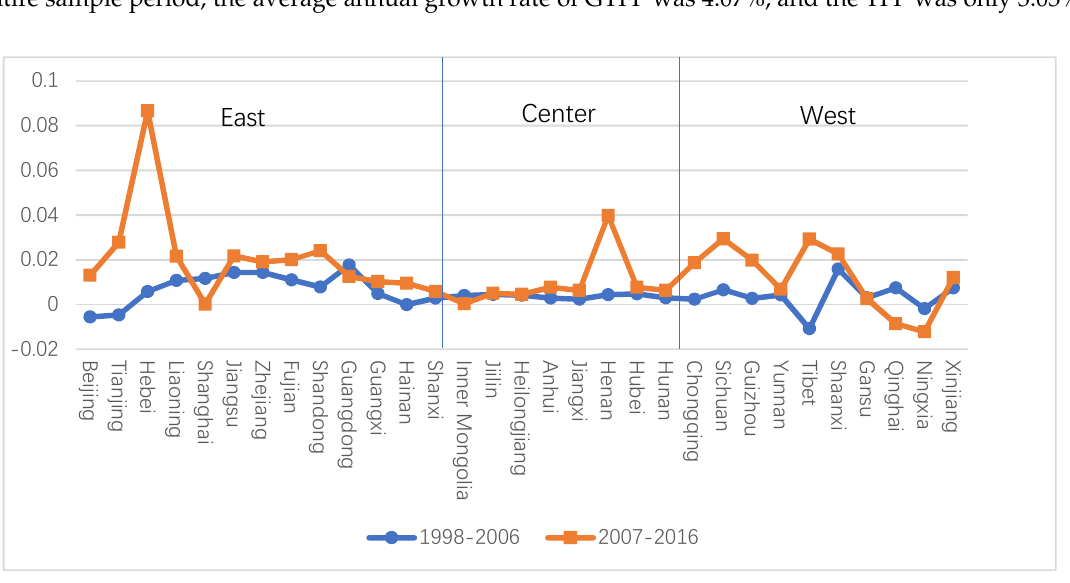
Figure 2. The mean gap between green total factor productivity index (GTFPI)and total factor productivity index (TFPI) in different periods in different provinces.